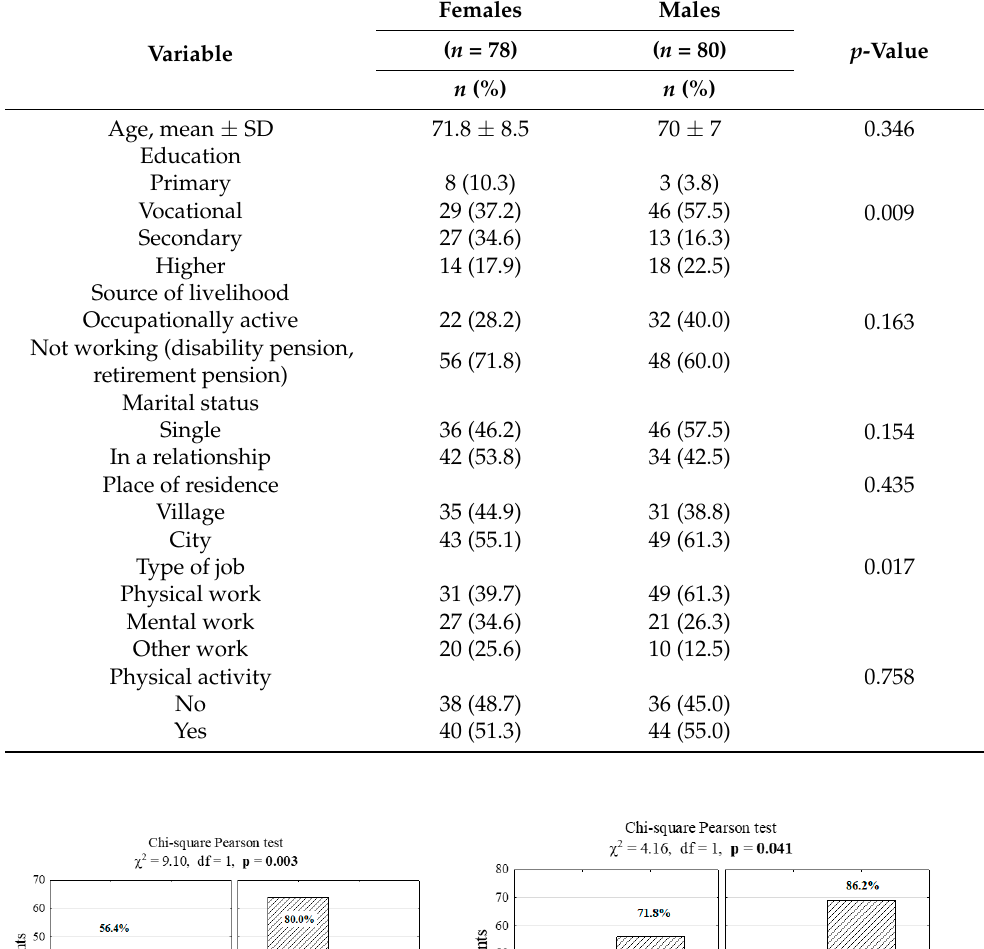
Table 1. Basic statistics for sociodemographic parameters characterizing the population of 158 pa- tients.